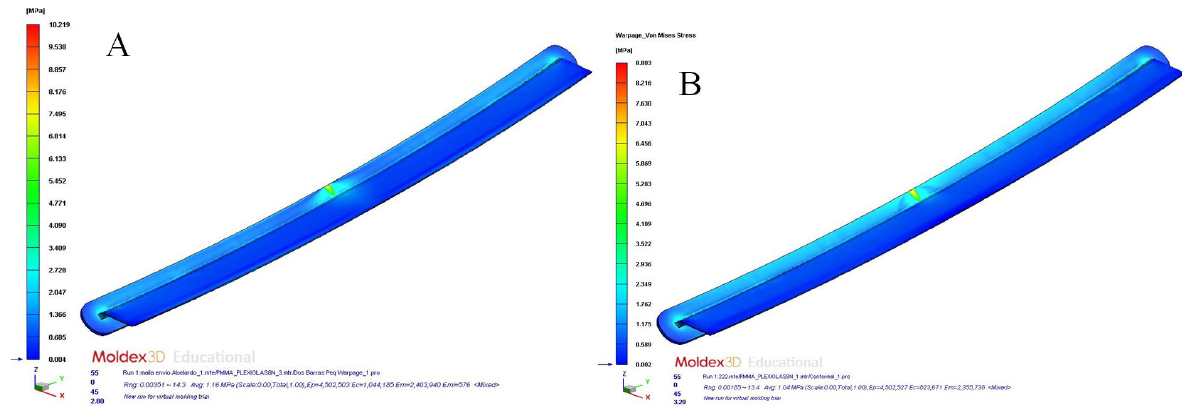
Figure 20. Warpage stress (MPa); conformal channels—dashed Fastcool bars ( A ), conformal chan- nels ( B ).